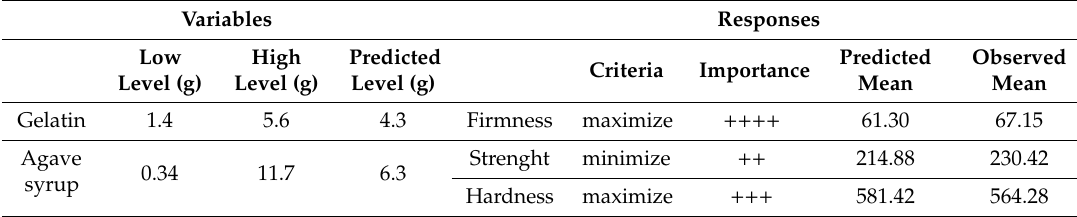
Table 3. Variables, intervals, and numerical optimization based on surface response design *.